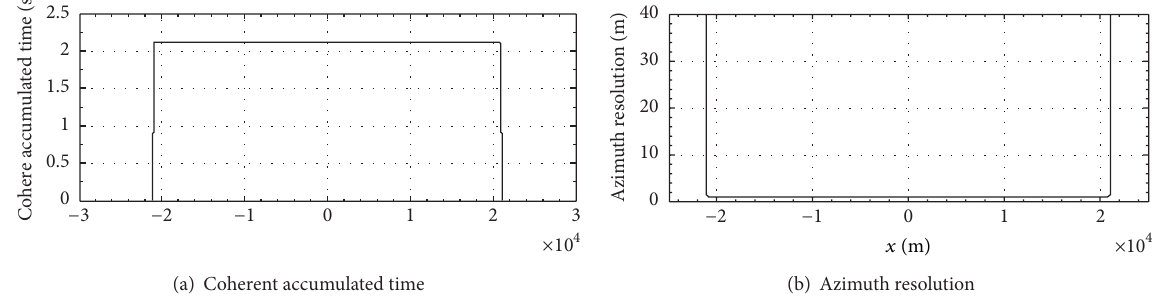
Figure 5: Coherent accumulated time (a) and azimuth resolution (b) ( 𝑡 0 = 𝑇 𝑠 /8 ).